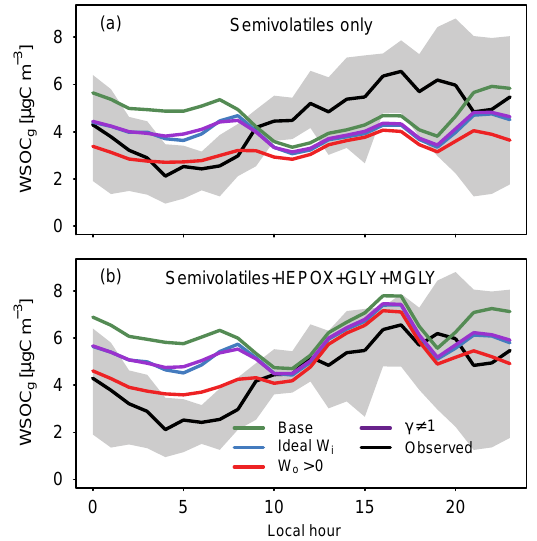
Figure 14. Observed WSOC g (Hennigan et al., 2009; Xu et al., 2016) and model SOA precursors considering only semivolatile sur- rogates (a) and semivolatile and aqueous surrogates (b) . Grey shad- ing represents the interquartile range of the observed data (mean in black). Colors represent different